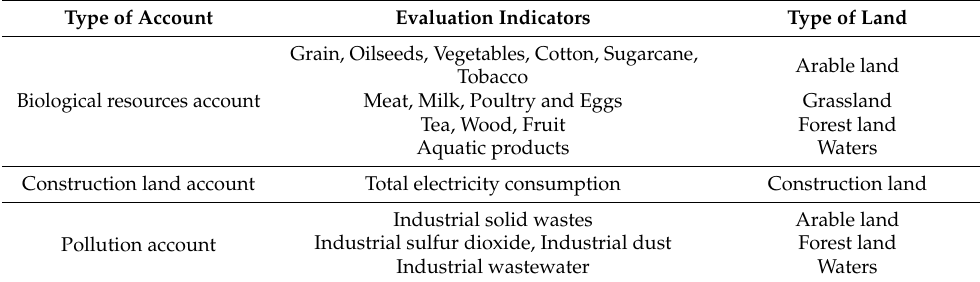
Table 1. Index System of